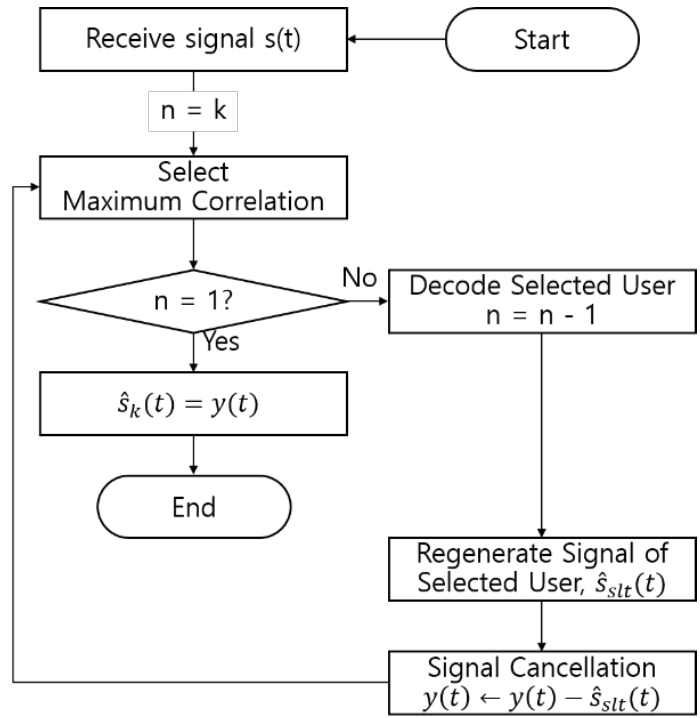
Figure 3. Diagram of a conventional successive interference cancellation (SIC) scheme.